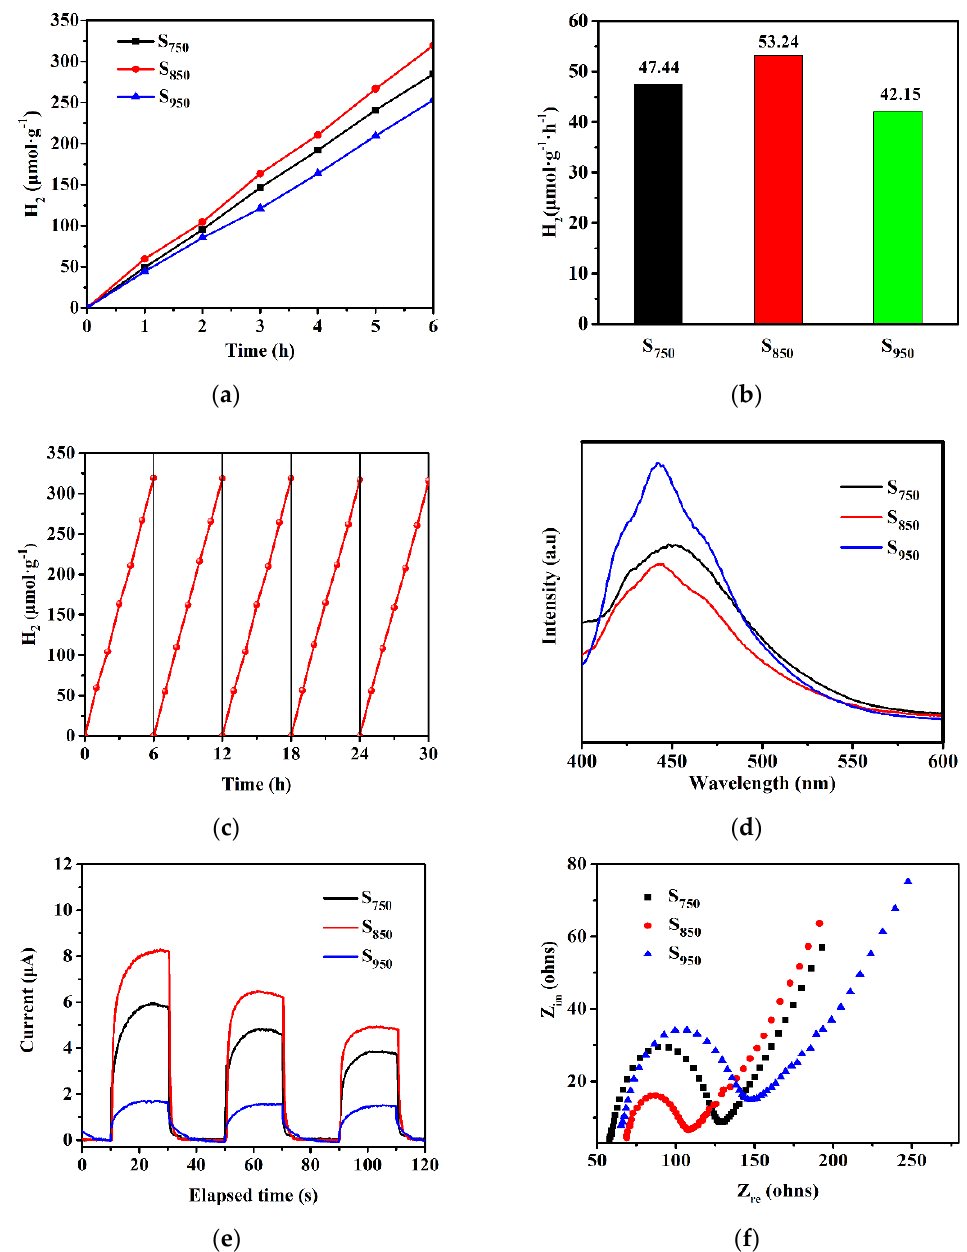
Figure 4. ( a ) Photocatalytic H 2 evolution and ( b ) H 2 evolution rates of Rh 2-y Cr y O 3 -loaded GaN:ZnO solid solution, ( c ) cycle stability of Rh 2-y Cr y O 3 -loaded S 850 , ( d ) photoluminescence spectra, ( e ) transient photocurrent, and ( f ) EIS Nyquist plots of S 750 , S 850 , and S 950 samples.